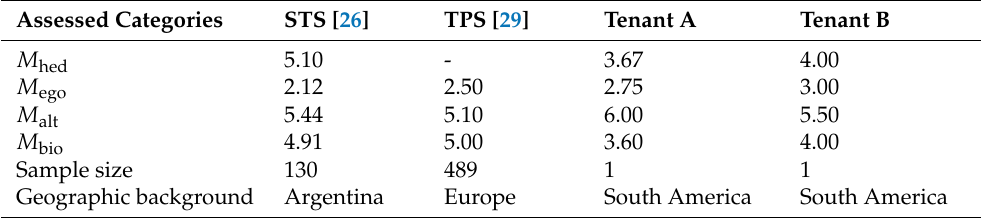
Table 5. Mean hedonic M hed , egoistic M ego , altruistic M alt and biospheric M bio values, as well as sample size and geographic background of studies dealing with sustainable transportation (STS) [26] and transport policy (TPS) [29], as well as the value scale results gathered from each Tenant A and Tenant B in the residential period at the